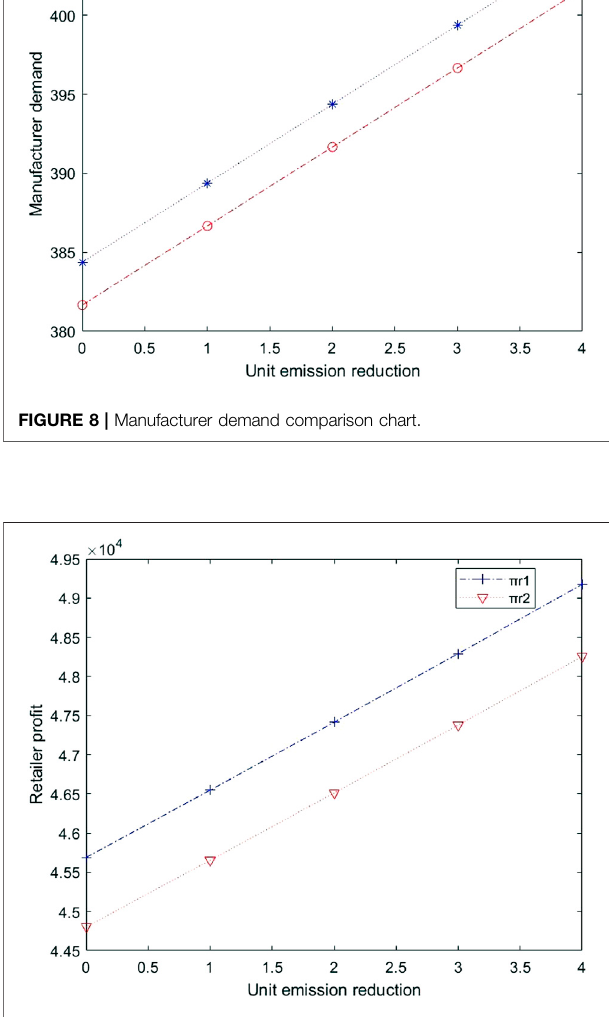
FIGURE 9 | Retailer pro fi t comparison